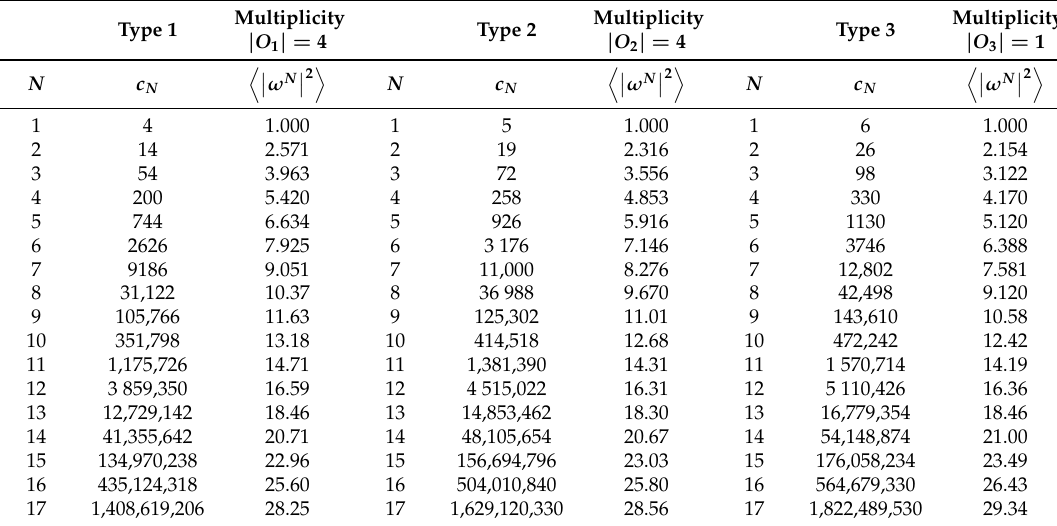
Table A2. SC lattice, tube cross section 2.0 ×